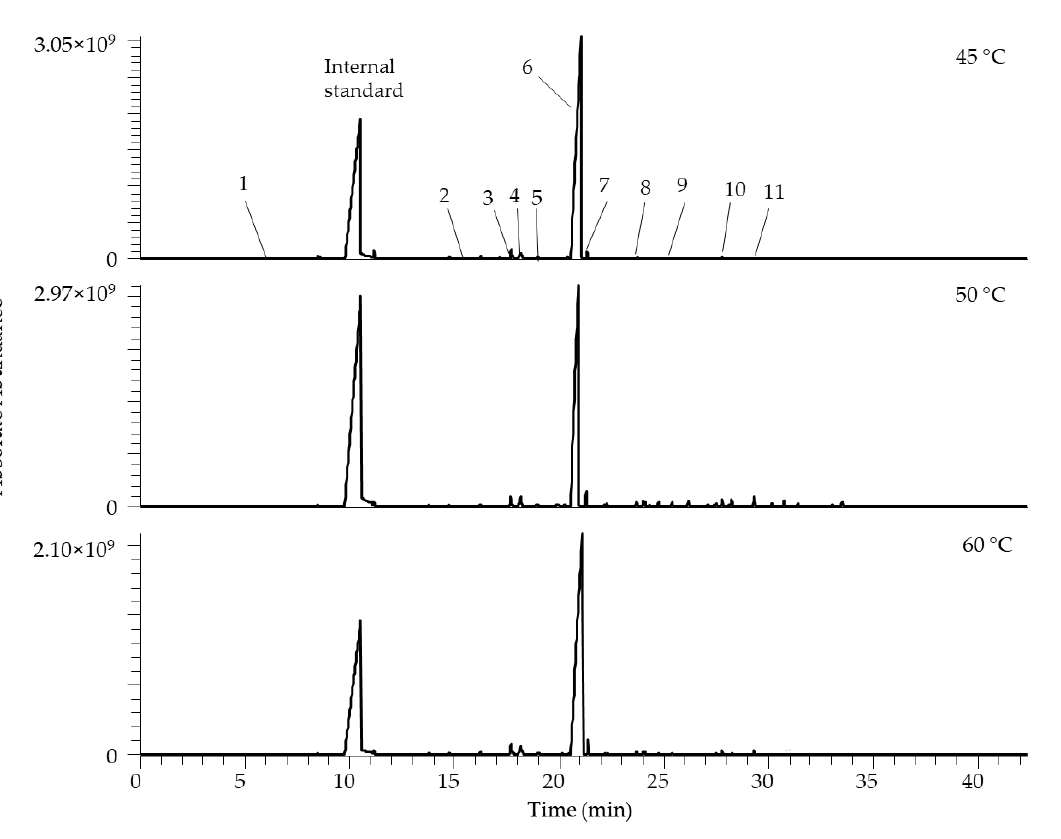
Figure 1. Chromatograms at extraction temperatures 45, 50 and 60 °C. (1) hexanal; (2) 3,5,5-trimethylcyclohex-3-en-1-one; (3) 2,6,6-trimethylcyclohexa-1,4-diene-1-carbaldehyde; (4) 3,5,5-trimethylcyclohex-2-en-1-one (isophorone); (5) 2,6,6-trimethylcyclohex-2-ene-1,4-dione (4-ketoisophorone); (6) 2,6,6-trimethylcyclohexa-1,3-diene-1-carbaldehyde (safranal); (7) 3,5,5-trimethyl-4-methylenecyclohex-2-en-1-one; (8) 7,7-dimethylbicyclo[4.1.0]hept-3-ene-2,5-dione; (9) megastigma-4,6(E),8(E)-triene; (10) 4-(2,6,6-trimethylcyclohex-1-en-1-yl)butan-2-one; (11) (E)-4-(2,6,6-trimethylcyclohexen-1-yl)but-3-en-2- one (β -ionone).